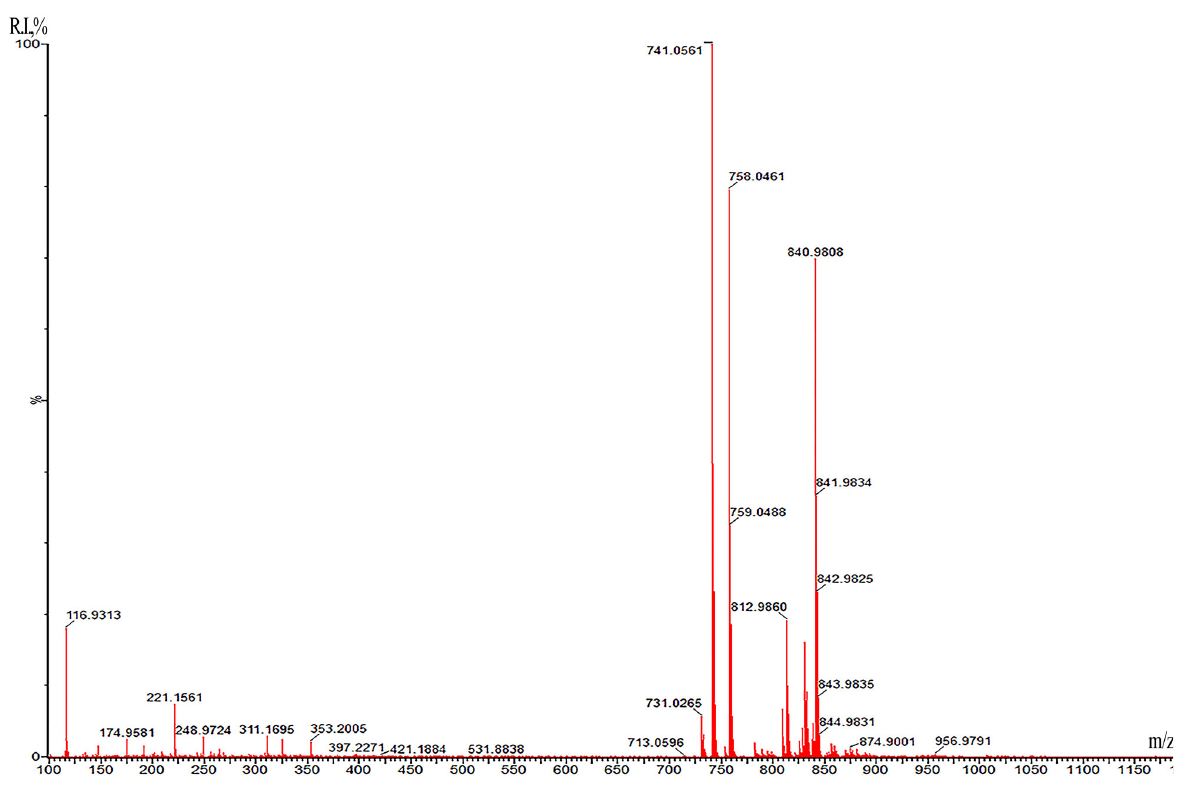
Figure 4. MS spectrum of the HPLC-MS analysis of the peak at 5.215 min.